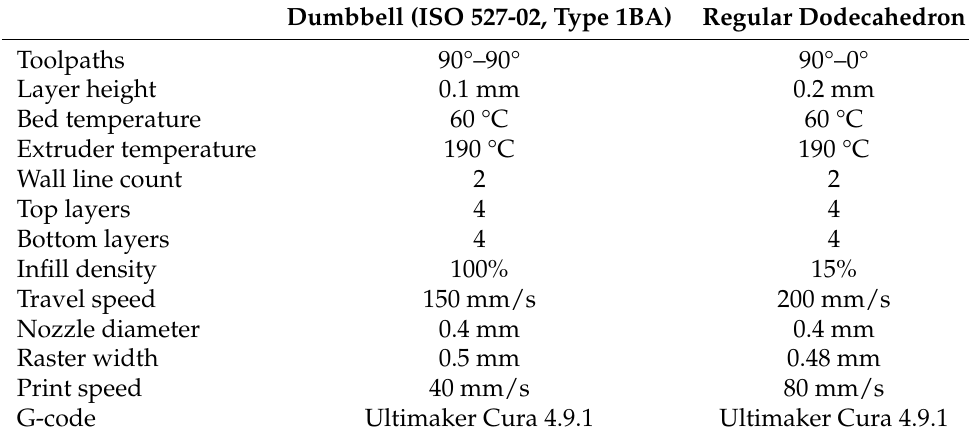
Table 1. Process parameters used for the fabrication of the printed samples (adapted from